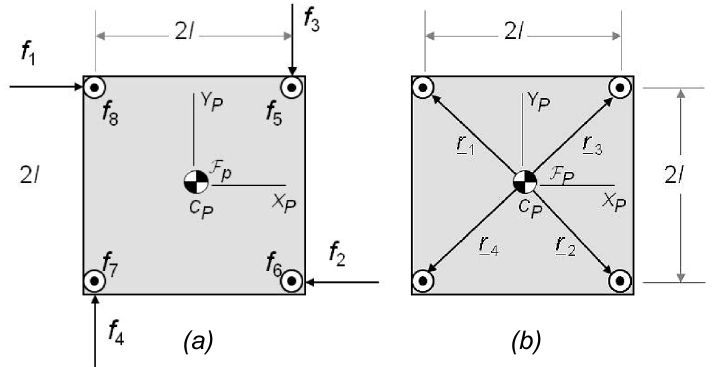
Fig. 7. Geometry: (a) Actuator and sensor positions [4], (b) Position